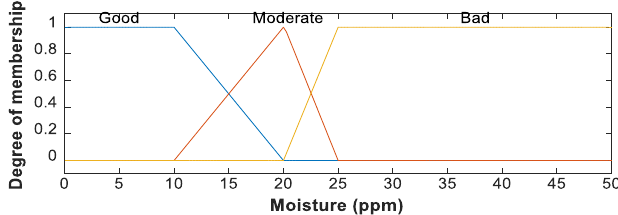
Figure 5. Membership functions for moisture content.